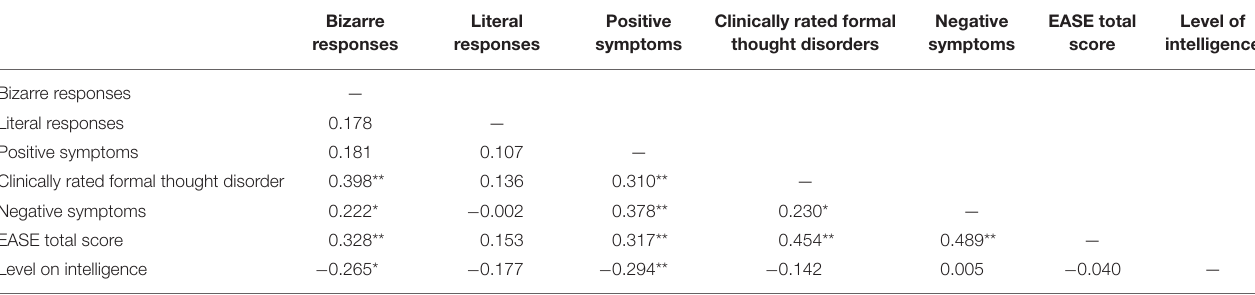
TABLE 3 | Correlation matrix Spearman ρ .